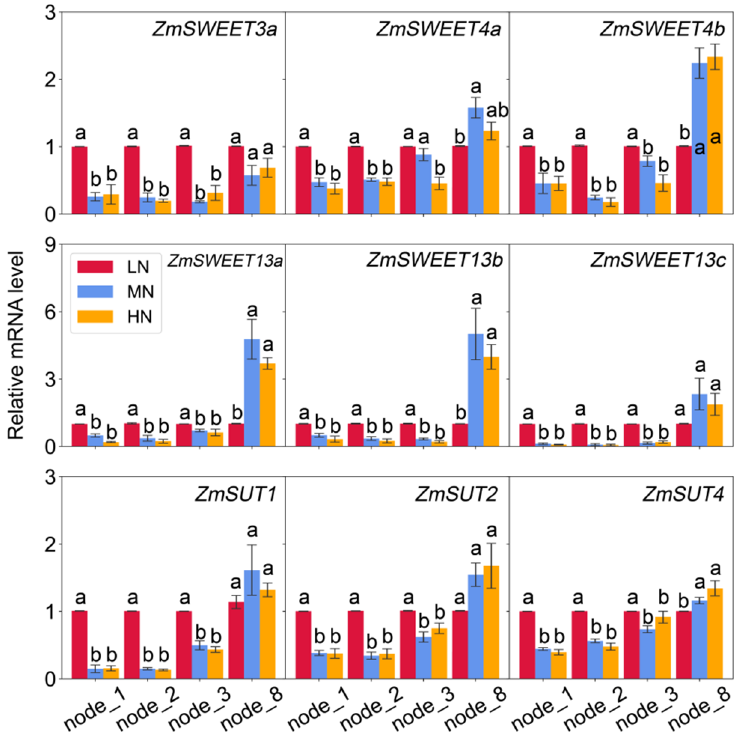
Figure 8. The relative expression level of genes putatively involved in sugar transport in nodes at 62 days after sowing. Columns with no letter in common are significantly different between nitrogen treatments in each panel ( p < 0.05). Vertical bars indicate the standard error of the mean ( n = 4).